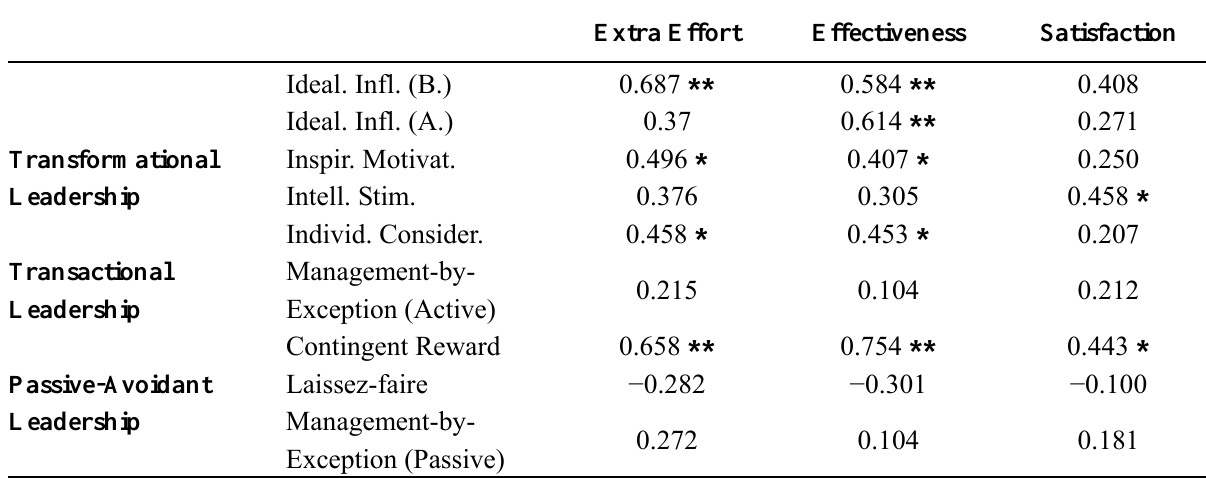
Table 6. Correlations between leadership dimensions and outcomes.